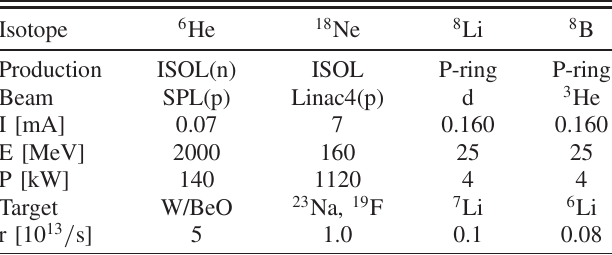
TABLE III. The rate (r) extracted from the source using different production methods ( 6 He estimated from experiments, for 18 Ne from experiments and calculations and rates for 8 Li and 8 B are estimated from